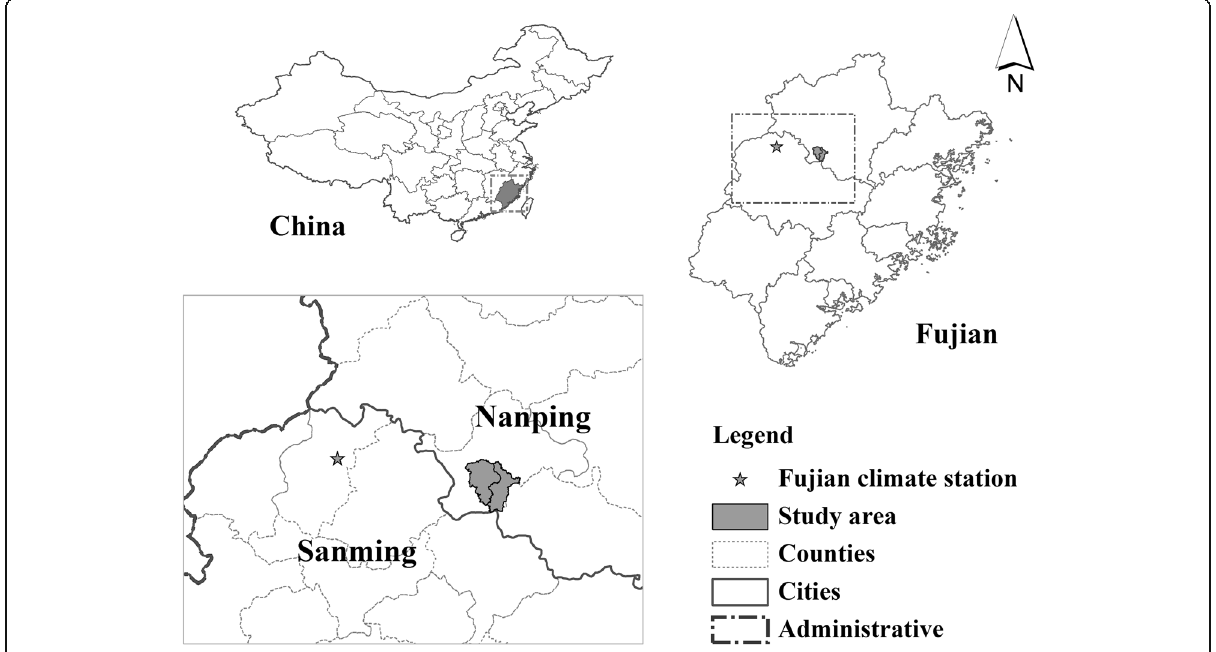
Fig. 1 A map showing the location of the specific study area and Fujian Climate